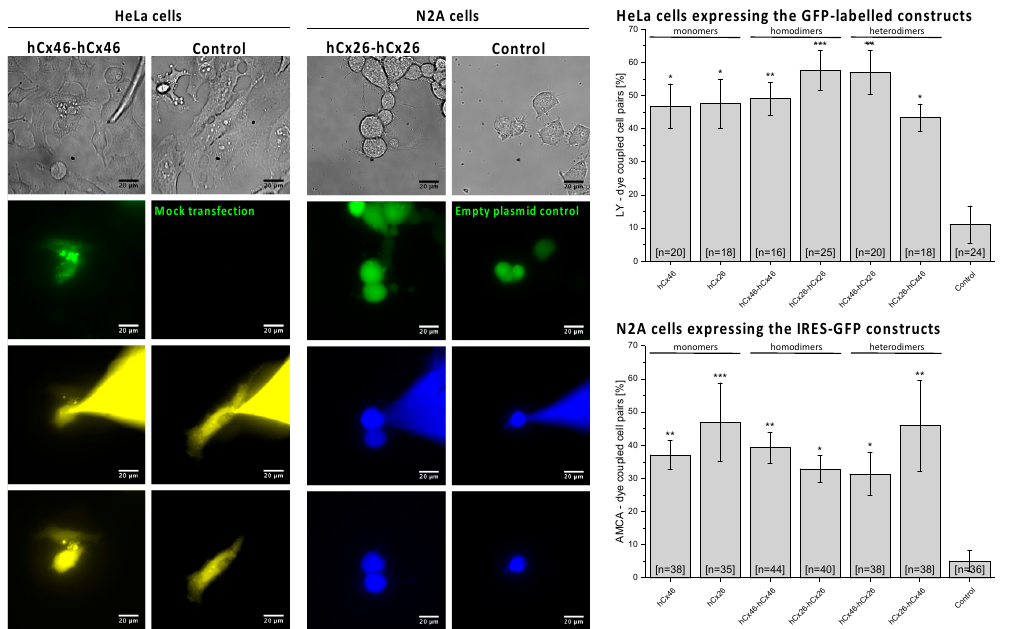
Figure 3. Analyzing the gap junction functionality by dye transfer experiments. A whole-cell patch-clamp configuration with a pipette solution containing 1 mg/mL Lucifer yellow was established on a HeLa cell pair expressing GFP-labelled monomeric hCx26 or hCx46 or one of the concatemeric variants. Mock transfected cells were used as control. The first row of the micrographs shows the phase contrast images of example experiments. In the second row, the GFP fluorescence signal before a dye transfer experiment is shown. The third and fourth rows show the fluorescence signal of the tracer dye 5 min and 10 min after establishment of the whole cell configuration. For the sake of clarity, the image in the fourth row was taken after removal of the dye filled capillary. Likewise, the experiments were performed with N2A cells. The cells were transfected with IRES-GFP constructs resulting in the expression of untagged constructs in the membrane and GFP in the cytosol. As control, cells expressing only GFP were used. The experiments were performed with a pipette solution containing 1 mg/mL AMCA, which could easily be distinguished from GFP under the fluorescence microscope. The cells were considered as coupled if the fluorescence intensity, which was measured in the unpatched cell of a cell pair after 10 min, was at least twice as bright as the background, which was measured at the beginning of the experiment. The probability of coupling (bar diagrams) was estimated as ratio of the sum of coupled cell pairs per the sum of tested pairs. The results are given as average. Error bars represent the SEM. The data were evaluated by a one-way ANOVA and post-hoc Tukey test (* p ≤ 0.05, ** p ≤ 0.01, *** p ≤ 0.01) in comparison to the control cells.